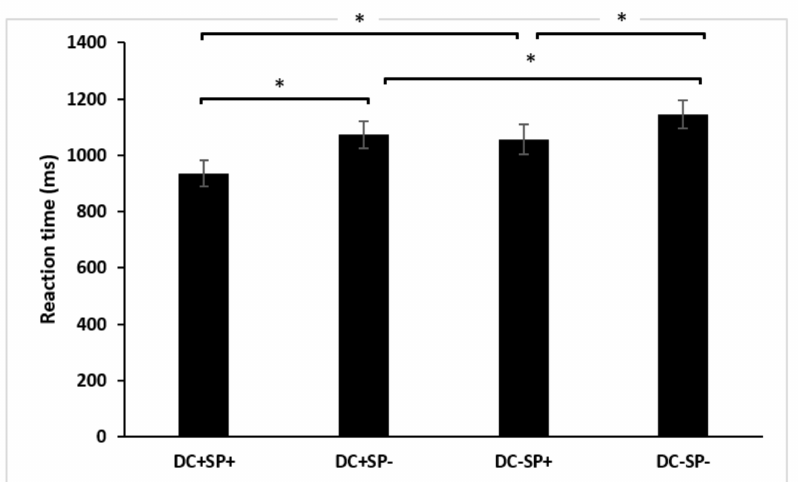
Figure 2. Mean reaction time for the combined metric and semantic dimension. Note. DC+: con- gruous duration; DC − : incongruous duration; SP+: semantically predictable; SP − : semantically unpredictable. The vertical lines correspond to the standard deviations. Asterisk means statistical significance ( p <